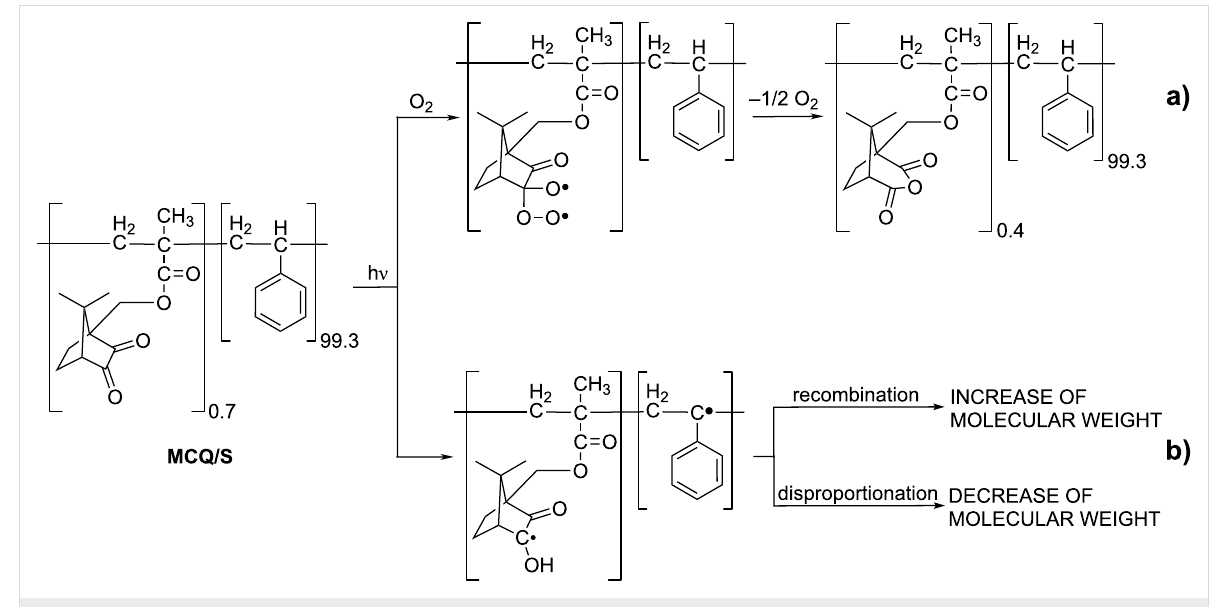
Scheme 4: Proposed mechanism of MCQ/S photochemistry.